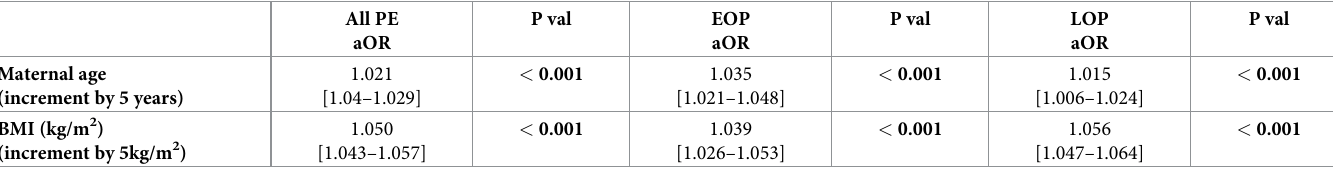
Table 3. Logistic bivariate regression analysis between maternal ages and pre-pregnancy BMI. All PE (all preeclampsia N = 1,736), EOP (N = 574) and LOP (N = 1,162) vs controls, no preeclampsia (N = 71,078).